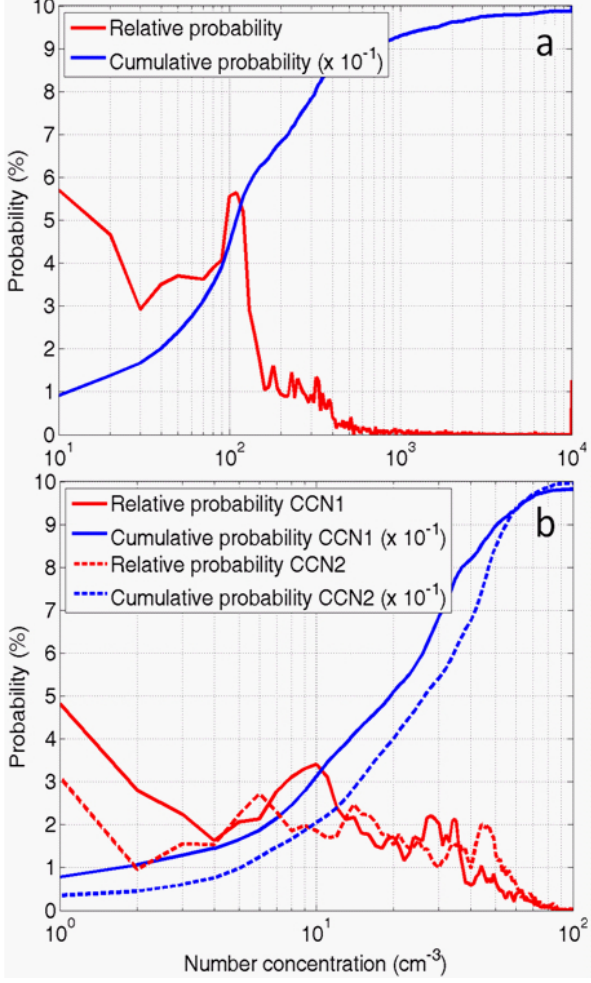
Fig. 18. Relative (red) and cumulative (blue) probability (%) of (a) all aerosols sampled with a differential mobility particle sizer system and (b) CCN from two instruments (solid and dashed) both set at 0.2% supersaturation, for the entire